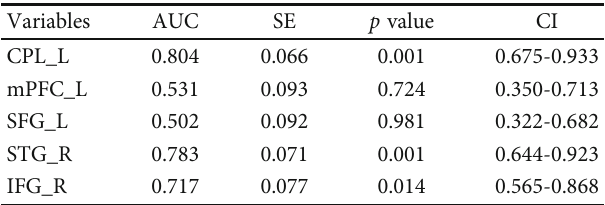
Figure 4: Correlations between clinical cognitive assessments and GMV in the mPFC_L (a) and STG_R (b) in di ff erent groups. GMV: gray matter volume; miniCog2: Mini-Cog assessment at the third month; MMSE2: Mini-Mental State Examination assessment at the third month; mPFC_L: left medial prefrontal cortex; STG_R: right superior temporal Table 5: Results of ROC curve analysis for classi fi cation of PSD and PSND patients.